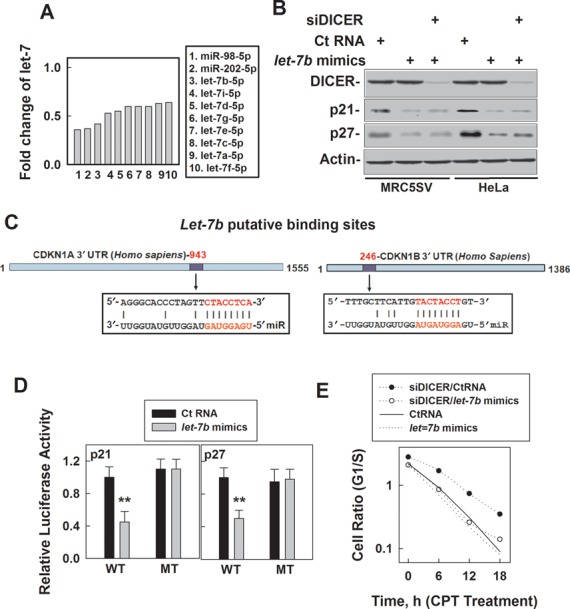
Knockdown of DICER-upregulated p21waf1/Cip1 and p27/Kip1 is due to the reduction of biogenesis of let-7. (A) Fold reduction of the human let-7 family members from the microArray of miRNAs from MRC5SV cells treated with siDICER compared with the cells treated with CtRNA. Whole RNA was extracted from the cells and 1 μg of RNA was used for miRNA microarray by LC Sciences Inc. (B) The effects of let-7b mimics on p21 and p27 expression in the cells with or without DICER knockdown. MRC5SV and HeLa cells were treated with control RNA or siDICER with or without let-7 mimics for 60 h and then the cells were collected for immunoblot detection. (C) Description of potential let-7b binding sites at the 3′-UTR of p21 (left) or p27 (right). (D) Relative luciferase activities were detected in 293FT cells treated with CtRNA or let-7 mimics at 48 h after transfection with the luciferase reporter vector containing either the wild type 3′-UTR of p21 or p27 (WT) or the 3′-UTR mutated (MT) at the potential binding site for let-7 (p21: mutated CTACCT to GATGGA; p27: mutated CTACCT to GATGGA). The data presented are the mean ± SD from three independent experiments that the authors carried out, **P < 0.01. (E) The effects of let-7b on the G1-S transition in DICER knockdowns. HeLa cells were collected for detecting G1 and S phase cell distribution as described in Figure 2B. Similar results were obtained from three independent experiments that the authors carried out.